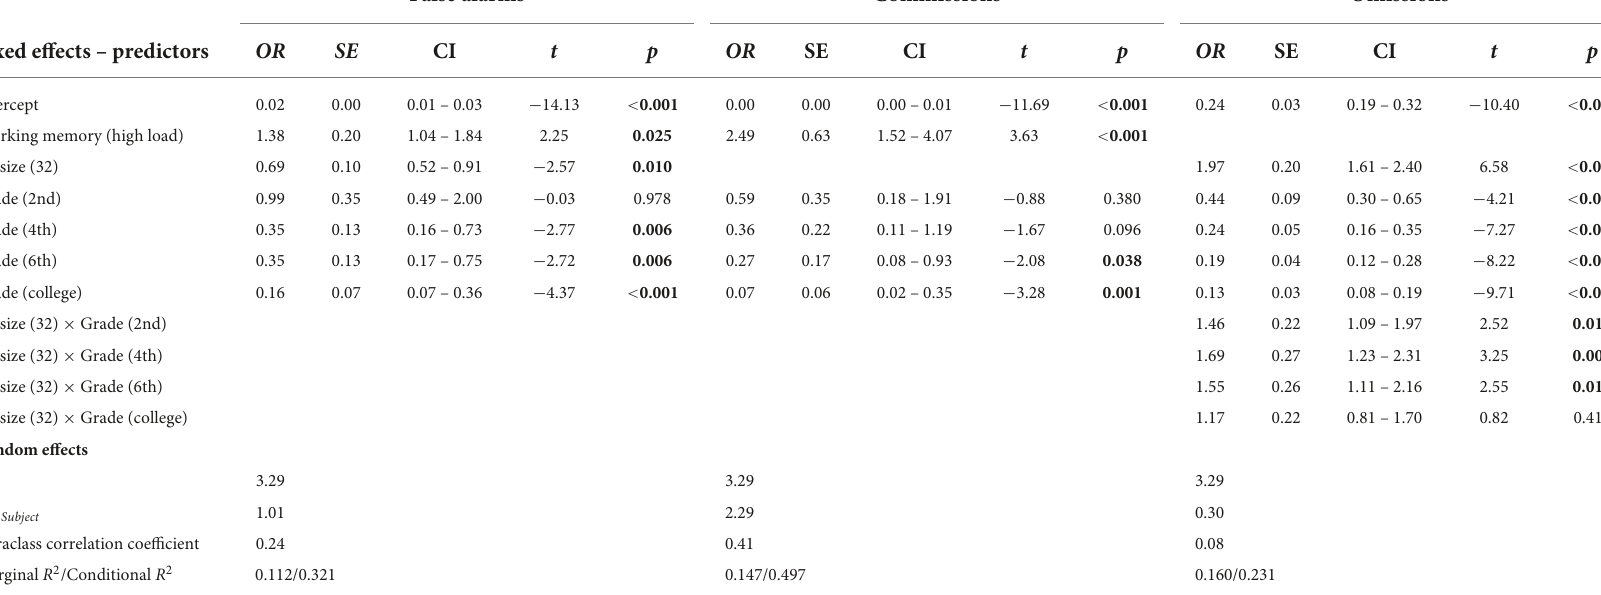
TABLE 3 Estimated coefficients for false alarms, commissions, and omissions (odds ratios) in the visual search task. False alarms Commissions